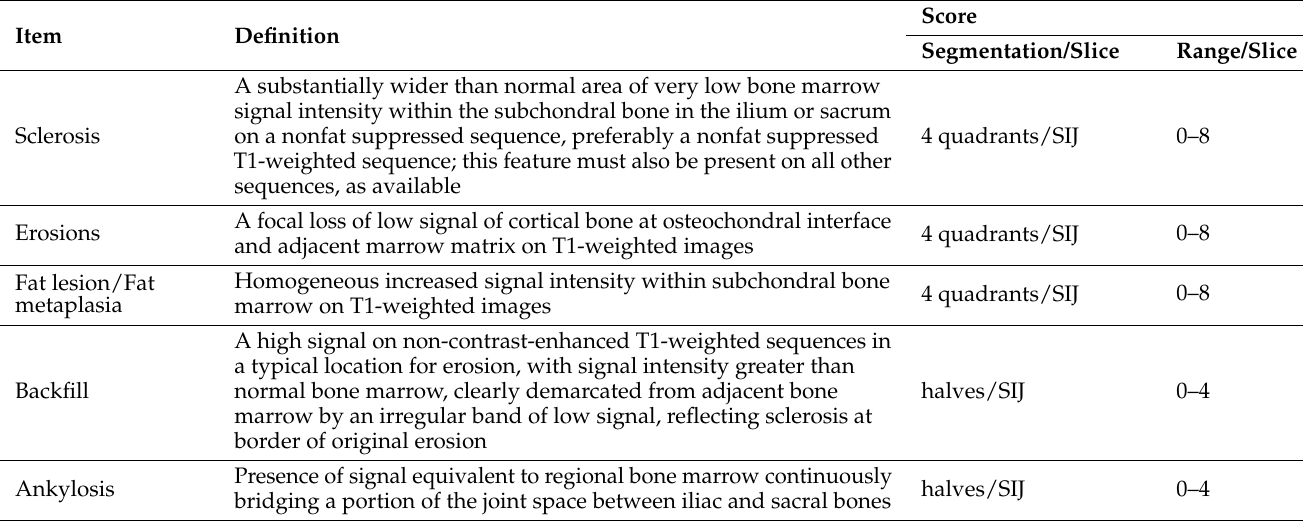
Table 3. Scoring system for assessing structural damage of the sacroiliac joint by MRI according to the JAMRIS-SIJ scoring